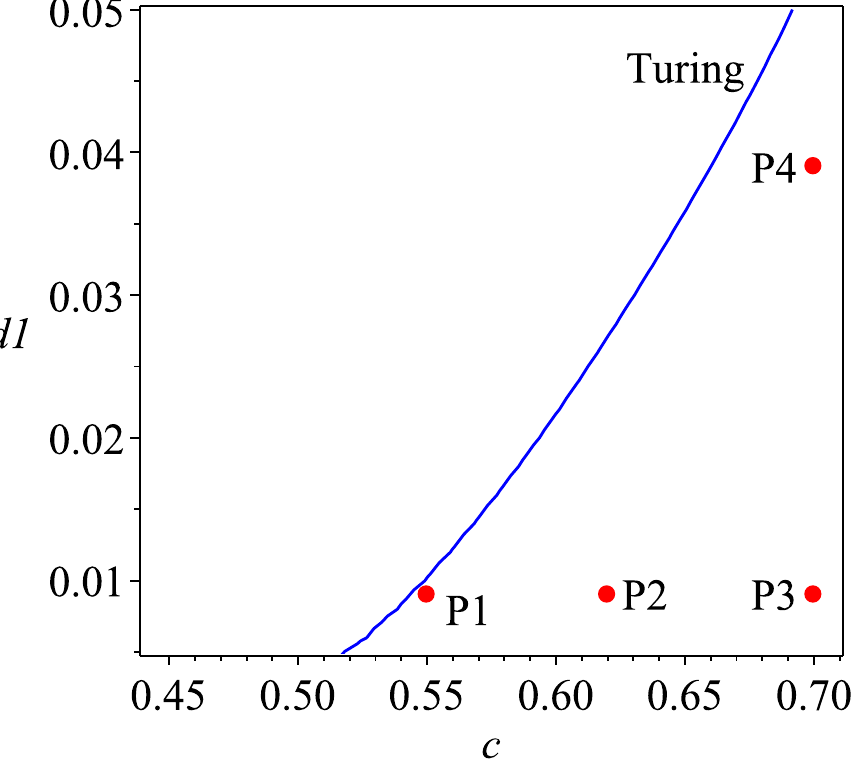
Figure 1. Bifurcation diagram for model (2) in the c − d 1 parameter space. The parameters are taken as a = 0.14, b = 0.02, s = 0.23, and d 2 = 0.24. The blue curve represents the Turing bifurcation curve, which divides the plane into two regions. The upper part of the blue curve is the stable region and the lower part is the unstable region. P 1 , P 2 , P 3 , and P 4 correspond to the parameter spaces of Figure 2, Figure 3, Figure 4, and Figure 5,